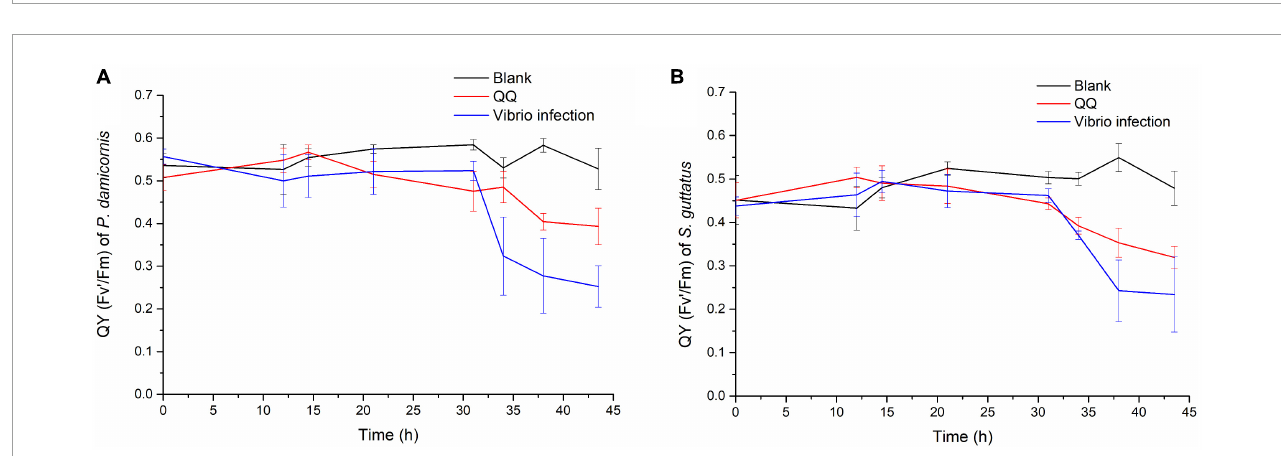
FIGURE4 Photosynthetic function of coral holobiont under bacterial infection and QQ treatment. The Qy (Fv’/Fm) of P. damicornis (A) and S. guttatus (B) was measured using PAM fluorimetry at 3 points of coral middle parts and 3 points of coral tip ends, to obtain the average value and standard deviation of each coral branch. The Qy from the V. fortis infected groups are presented in blue line, those infected groups with additional treatment of QQ enzyme are presented in red line, and the blank groups in black